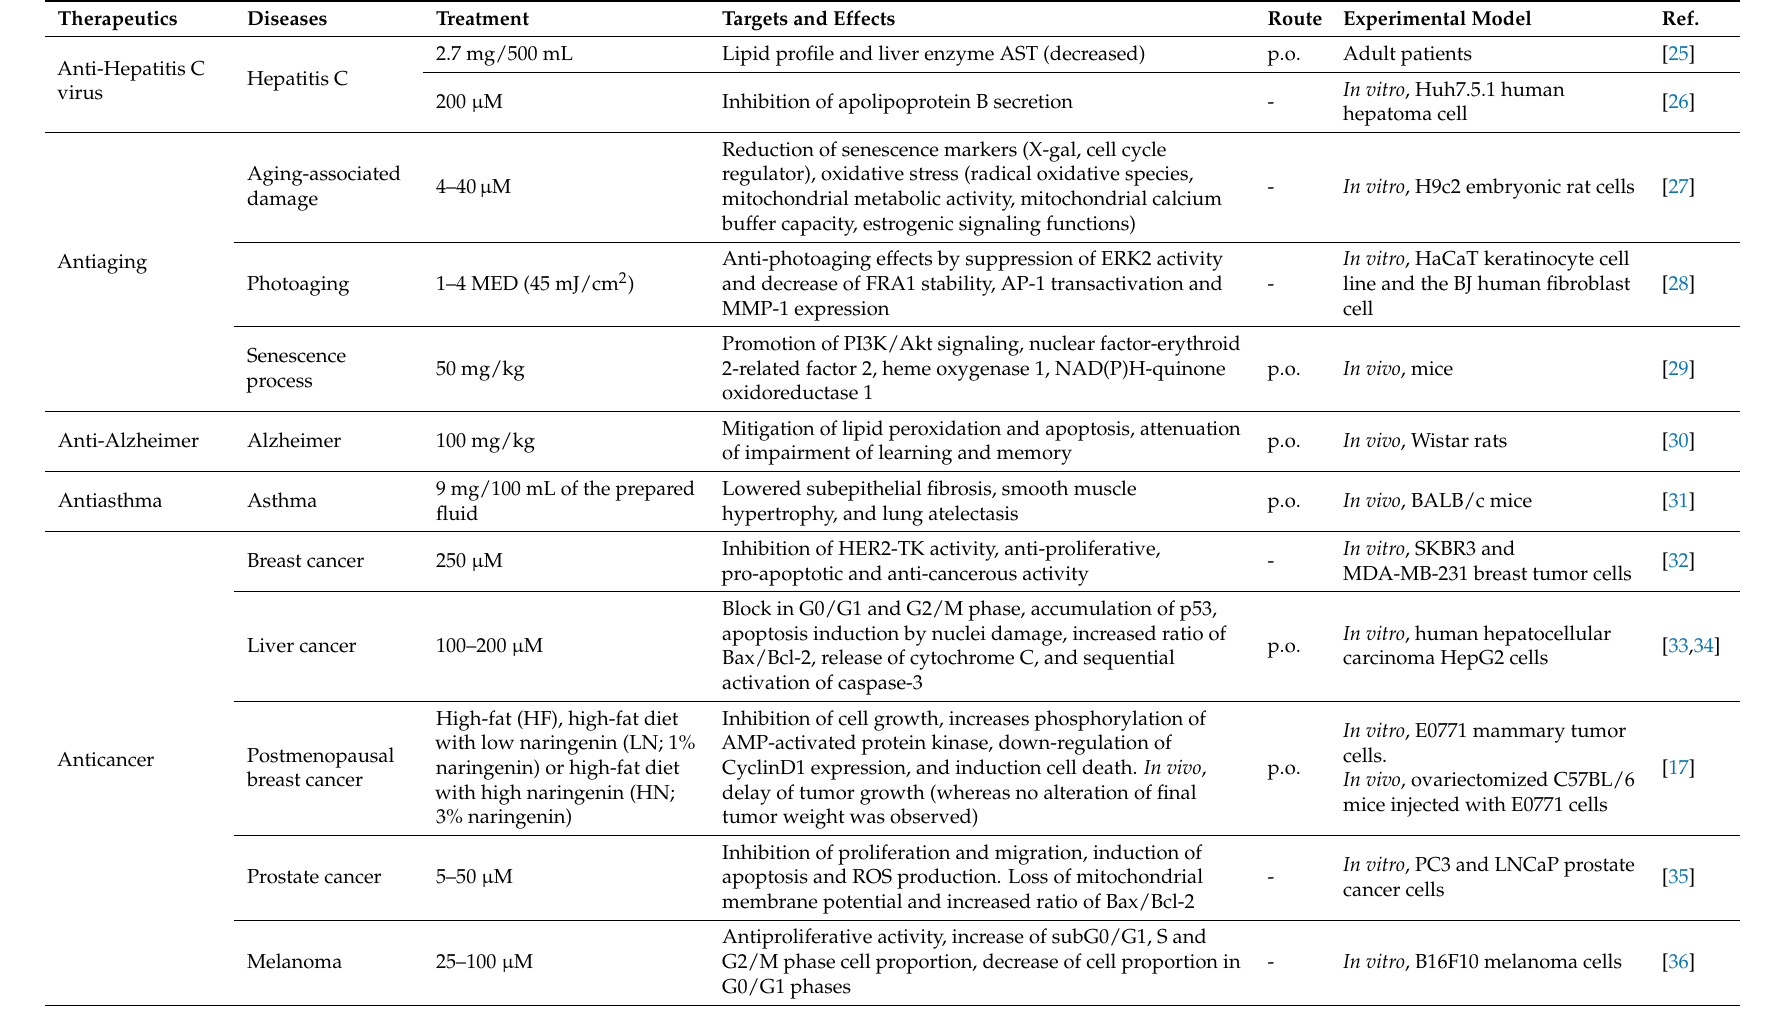
Table 1. Comparison of effective naringenin doses in various disease